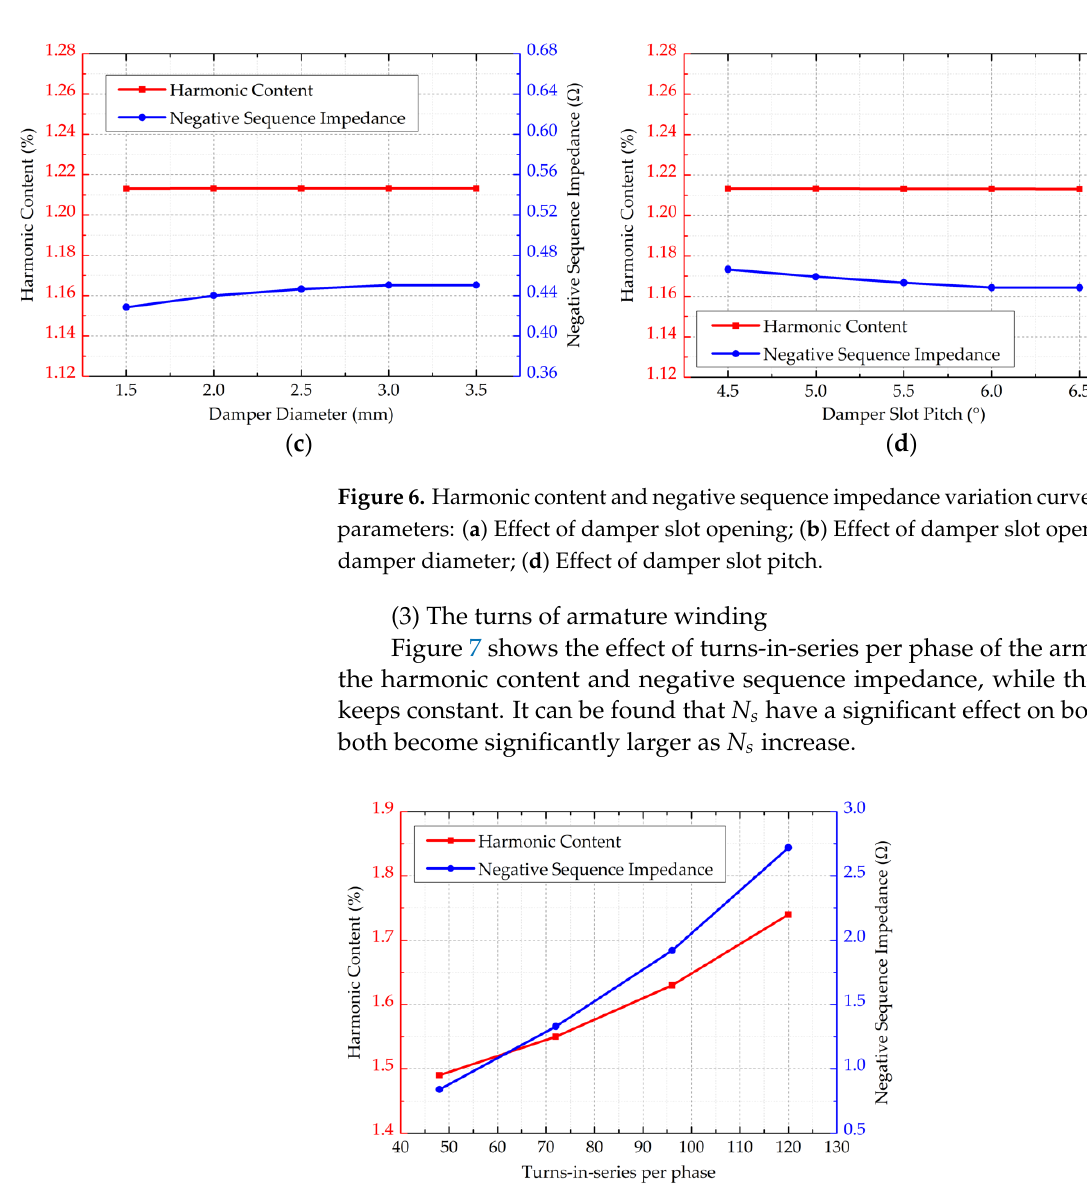
Figure 7. Harmonic content and negative sequence impedance variation curve with armature winding turn.